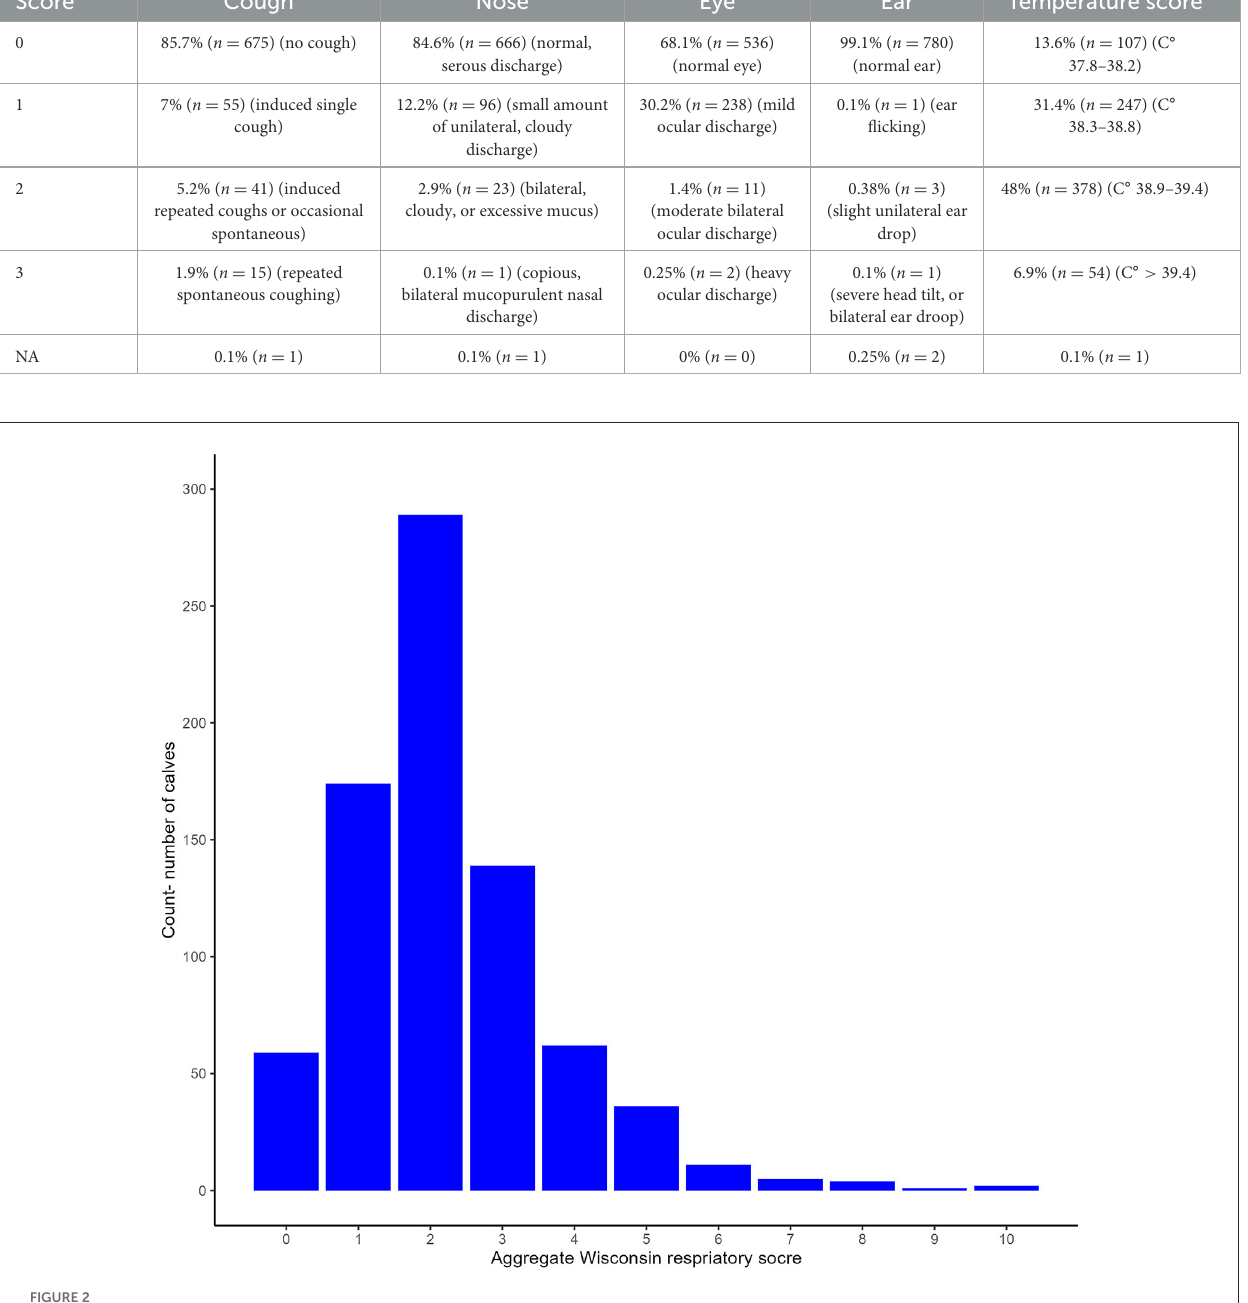
estimate but a minor increase in the 95% BCI going from (1%, 8%) to (1%,